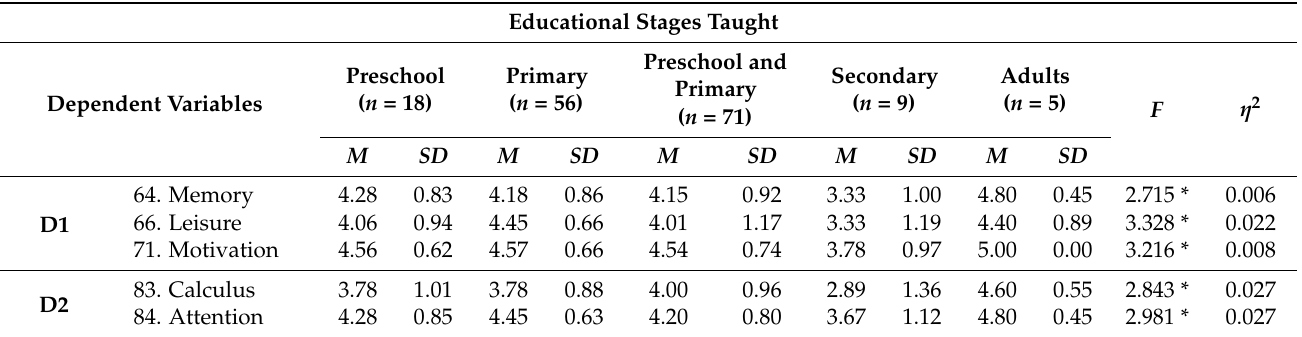
Table 11. Significant differences in the benefits and uses of apps as a function of the educational stage taught by teachers from